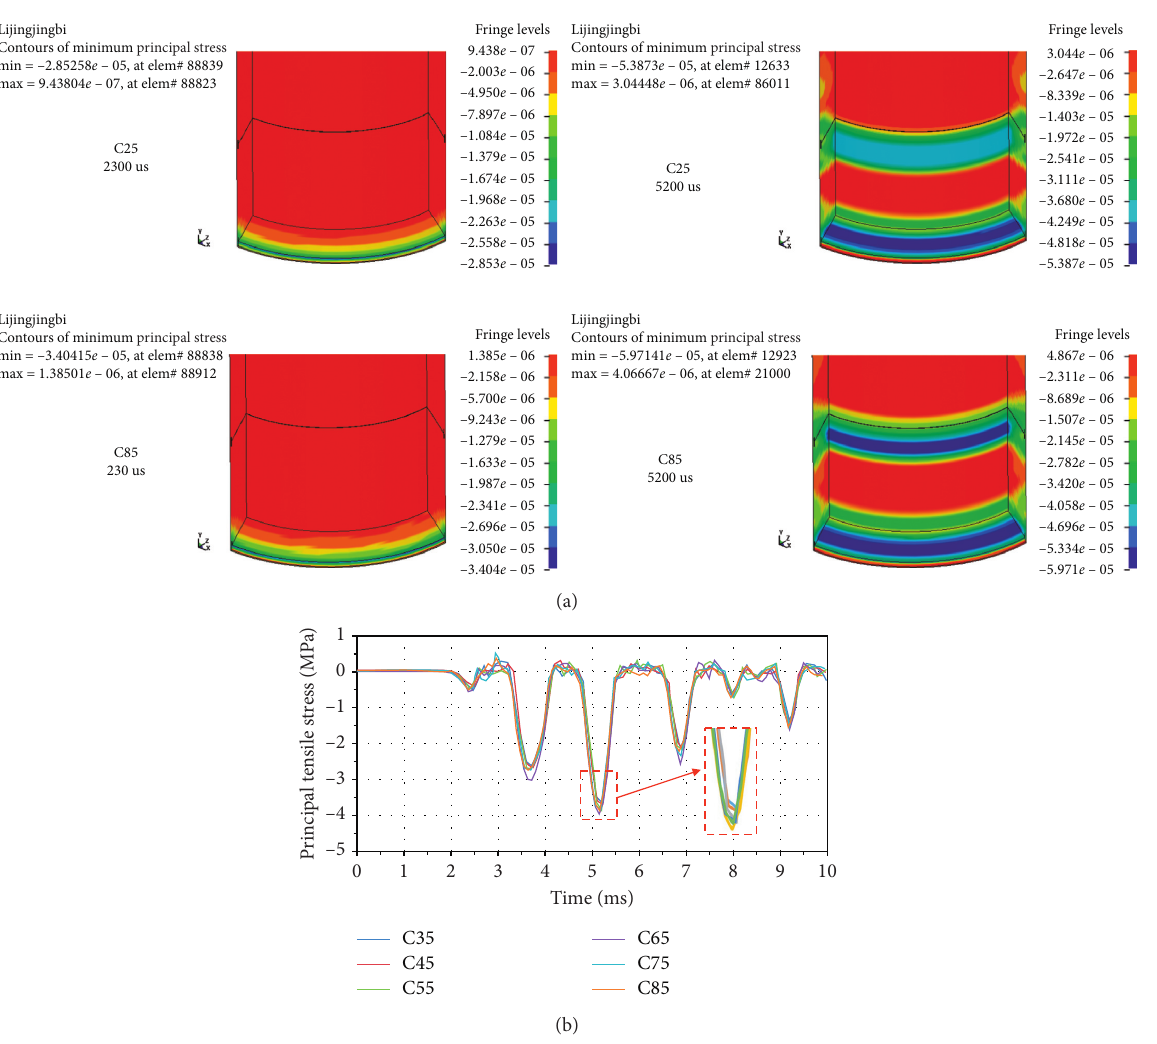
Figure 10: Principal tensile stress of the steel central position with various concrete strengths. (a) Nephogram of the principal tensile stress at the center of the steel plate. (b) Principal tensile stress curves with different concrete